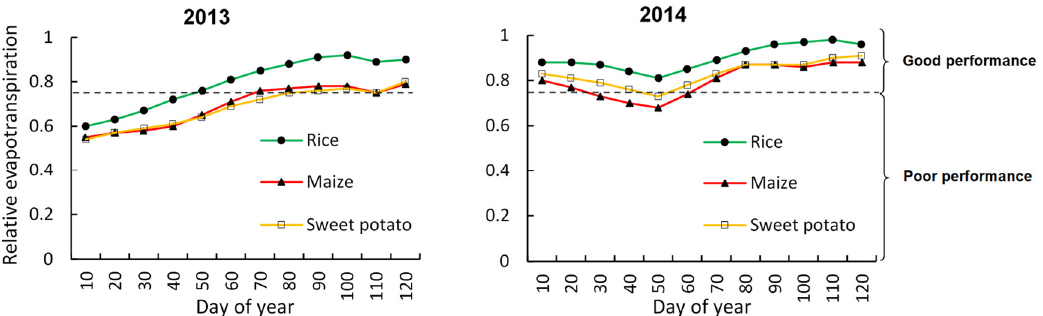
Figure 10. Variation of the relative evapotranspiration of paddy rice, maize, and sweet potato crops in KVIS during January–April 2013 and 2014. Dashed lines represent the thresholds for distinguishing between irrigated areas with poor or good performance.